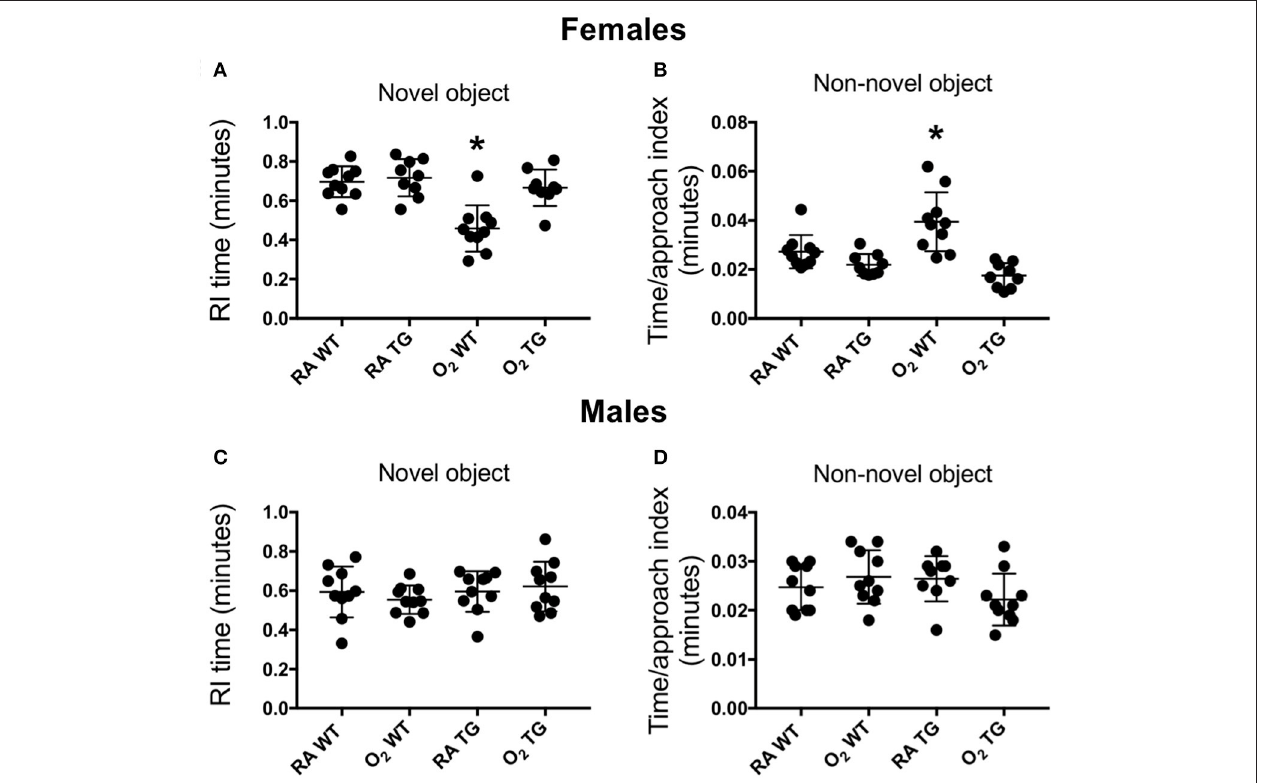
FIGURE 2 | Over-expression of EC-SOD in the lung preserves the ability to learn in adult female mice exposed to neonatal hyperoxia. Novel object recognition testing was evaluated separately in female (A,B) and male (C,D) adult wild type (WT) and Sftpc EC − SOD transgenic (Tg) mice that were exposed to room air (RA) or 100% oxygen (O 2 ) between postnatal days (PND) 0–4. A recognition index (A,C) based on the proportion of total time spent in contact with the novel object, as well as a time per approach index (B,D) based on the proportion of total time spent approaching the non-novel object were measured to assess learning. Neonatal hyperoxia significantly decreased recognition of the familiar object in female WT mice ( A , * P < 0.0001) but not in Tg mice ( B , P = 0.28). Neonatal hyperoxia significantly increased recognition of the familiar object in female WT ( C , * P < 0.002) but not in Tg mice ( D , P = 0.25). n = 9–10 mice per group. Values from individual mice are represented as